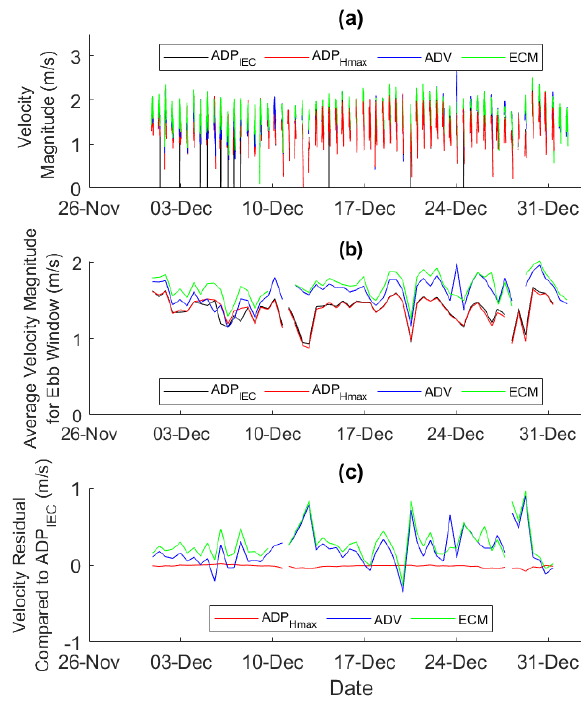
Fig. 4. (a) Velocity magnitude for each ebb window (b) Average velocity for each ebb window (c) Residual velocity when subtracted from ADP IEC data set.